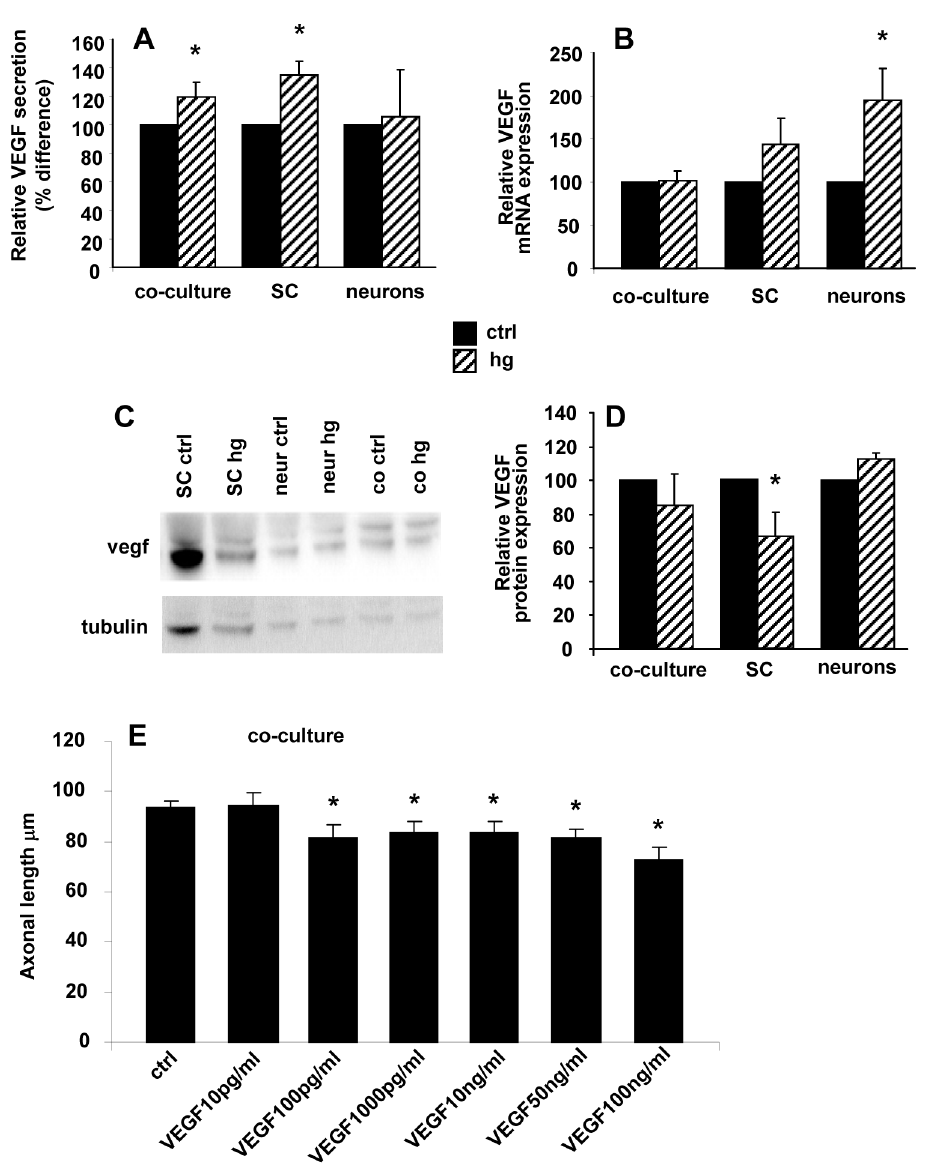
Figure 5. Hyperglycaemia-induced post-translational regulation of VEGF. (A) Exposure to glucose 45 mM for 24 hours increased the level of secreted VEGF in neuron-SC co-cultures and SC monocultures. Data are express as percentage difference between their own control in independent experiments ( n =5) *p , 0.05. (B) Hyperglycaemia significantly increased VEGF mRNA only in neuron monocultures ( n =5). (C) Representative and (D) quantitative western blot (WB) demonstrating VEGF decrease in hyperglycaemia-conditioned SC monocultures compared with control SC monocultures. VEGF level was not affected in neuron monocultures. Data are expressed as mean 6 SEM of independent experiments ( n =4) *p , 0.05 vs controls. (E) VEGF induced a significant reduction in axonal outgrowth in neuron/Schwann cells coculture. Data are expressed as mean 6 SEM of independent experiments ( n =3) *p , 0.05 vs controls. doi:10.1371/journal.pone.0108403.g005 cyclophilin A 165 6 39 vs hg 223 6 5; p , 0.05) and increased FLT-1 protein in SC monocultures (183.6 6 41.8 p , 0.05 vs hg 61 6 11). sFLT-1 level remained unchanged in DRG co-cultures (61.6 6 3.9